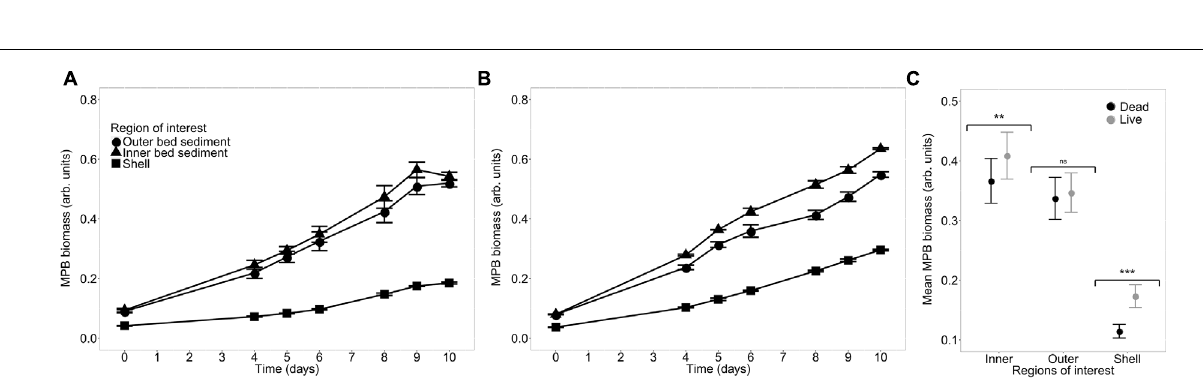
FIGURE 5 | MPB biomass as a function of time (mean ± SE, n = 3) averaged over the three regions of interest in treatments with dead (A) and live (B) C. fornicata , and mean MPB biomass for each combination of treatment and ROIs (C) . ns not significant ( p > 0.05), ∗∗ p < 0.01, ∗∗∗ p < 0.001.